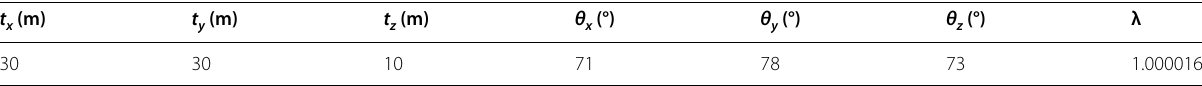
Table 10 Simulative true values of transformation